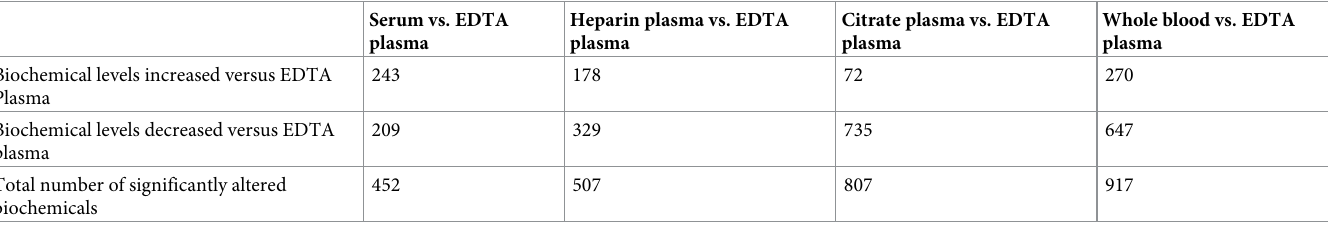
Table 1. Number of significantly altered biochemicals in blood collected in different tube collection